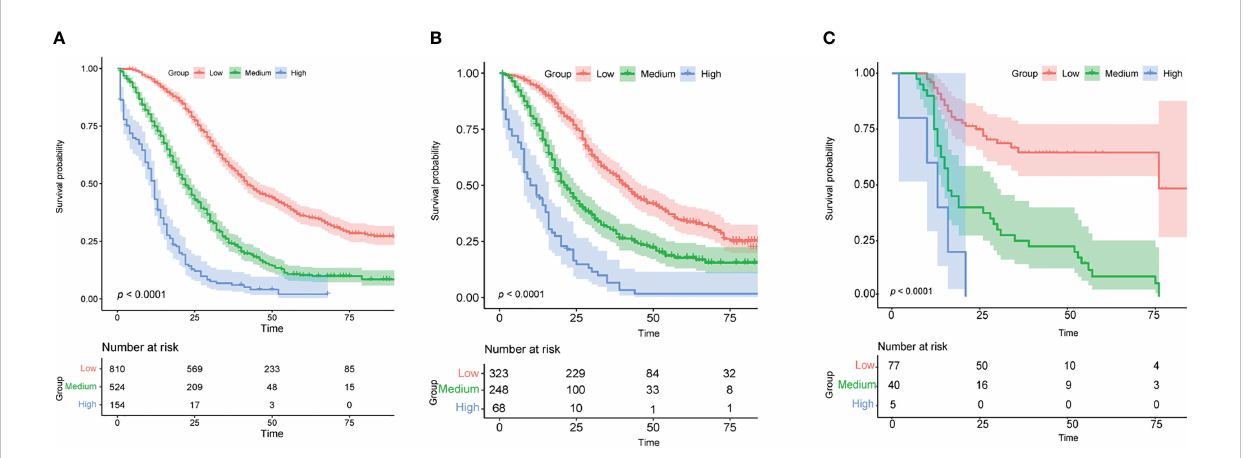
FIGURE 6 Analysis of survival based on risk strati fi cation. Kaplan-Meier for patients categorized as low-risk, medium-risk, or high-risk in the training cohort (A) , validation cohort (B) , and testing cohort (C)